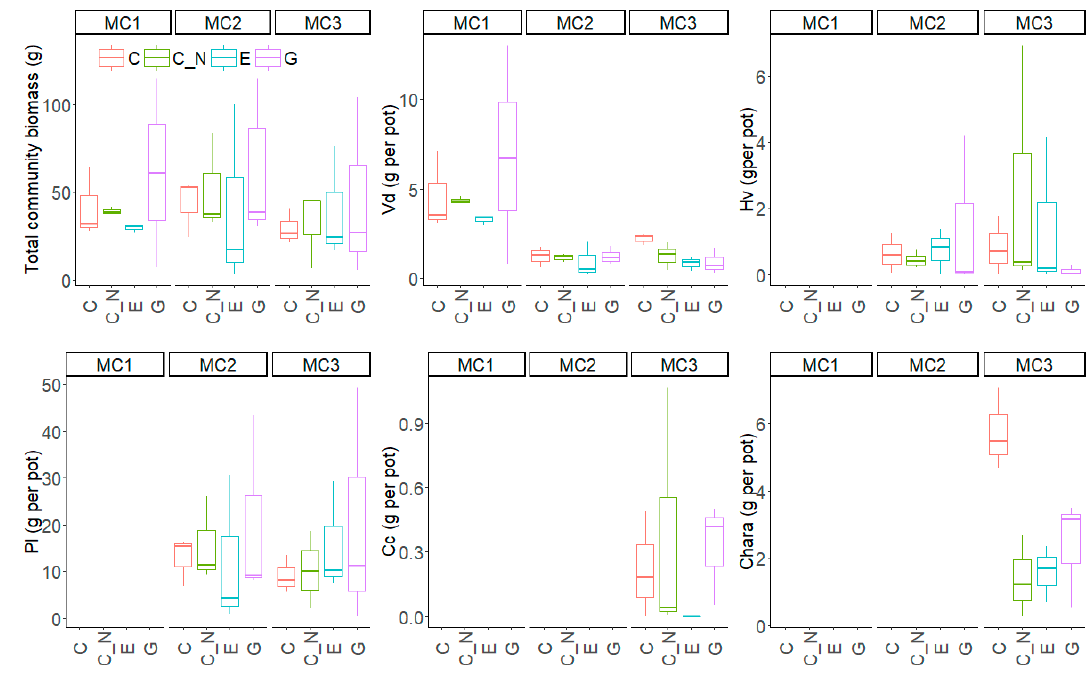
Figure 3. Total community biomass and biomass of five submerged macrophytes species (per pot) during the experiment for the three macrophyte community treatments (MC1, MC2 and MC3) and the four extreme precipitation treatments (EP: C, C_N, E and G). Vd = Vallisneria denseserrulata ; Hv = Hydrilla verticillata ; Pl = Potamogeton lucens ; Cc = Cabomba caroliniana ; Chara = Chara sp. Water 2019 , 11 , 1160